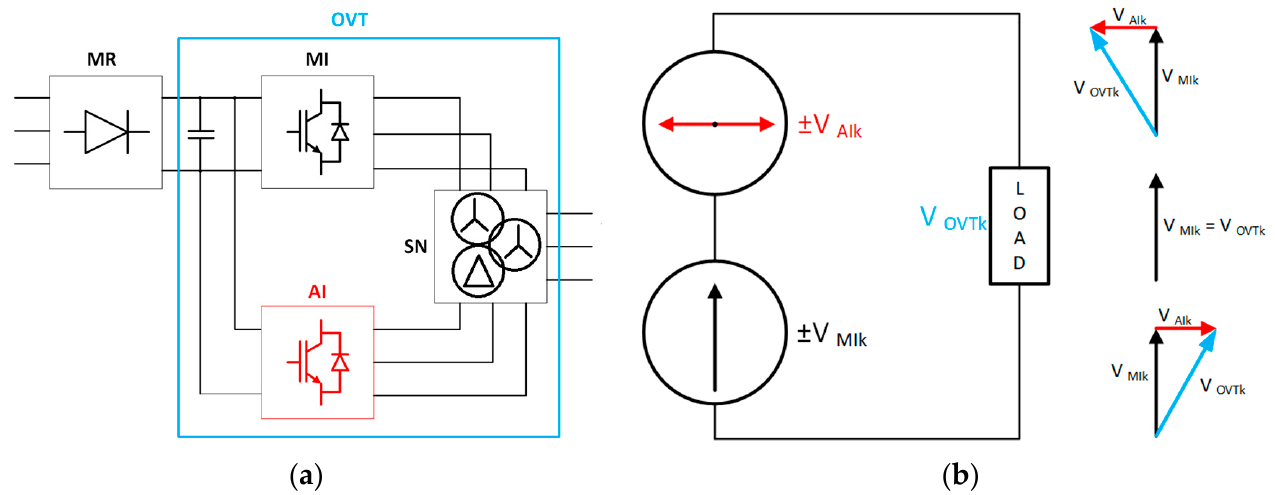
Figure 1. Scheme ( a ) and concept of the vectors ( b ) in the OVT inverter. The ( α , β ) plane of the stationary coordinate system is divided into six equal k sectors corresponding to the active vectors V MIk of the main inverter. Each sector of the plane accommodates three different output vectors V OVTk generated by the OVT converter: two vectors as a result of the sum of the corresponding orthogonal vectors V MIk